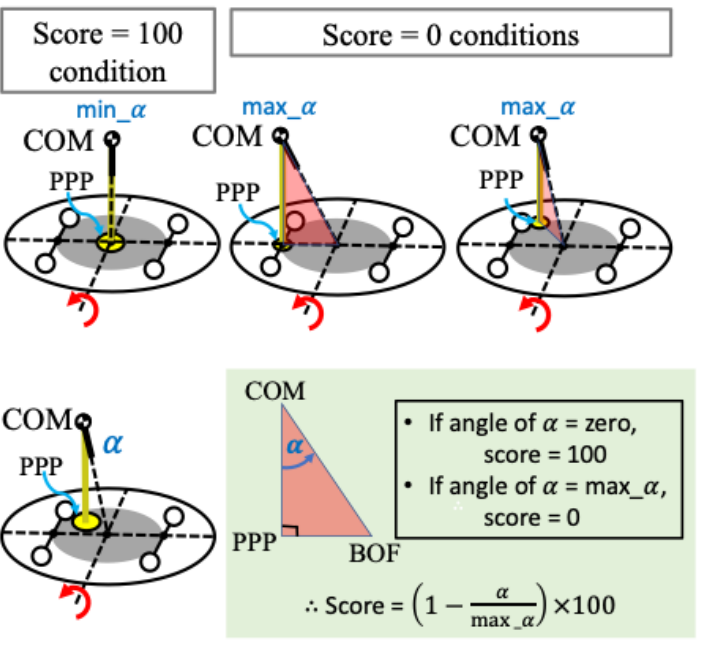
Figure 5. An explanation for the proposed algorithm to score the human body-balance ability on the wobble board (HBBAWB) through the geometric solution under the boundary condition.